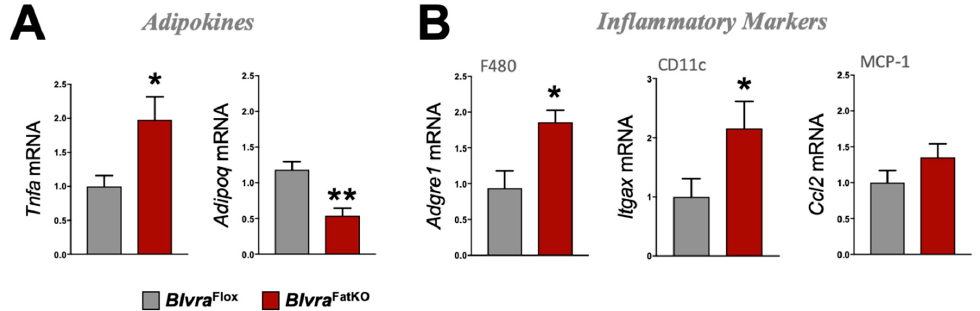
Figure 4. Adipokine and inflammatory marker expression in WAT from Blvra Flox and Blvra FatKO mice fed a high-fat diet. ( A ) Tnfa and Adipoq , and ( B ) Adgre1 , Itgax , and Ccl2 mRNA expression in WAT. *, p < 0.05 (vs. Blvra Flox ). n = 4 / group Blvra Flox ; n = 5 / group Blvra FatKO